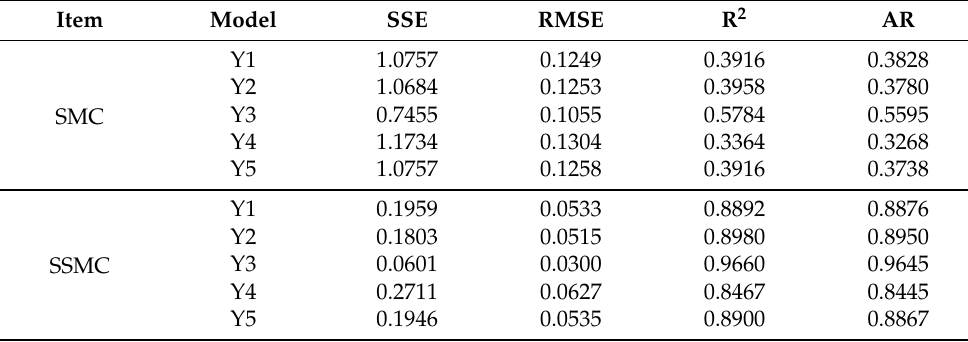
Figure 7. SSMC and NDVI model results. Table 4. Evaluation of the soil moisture content construction